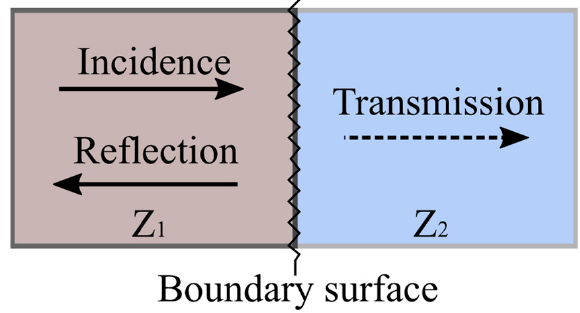
Figure 2. Reflection and transmission of elastic waves. Table 1. Medium conditions.